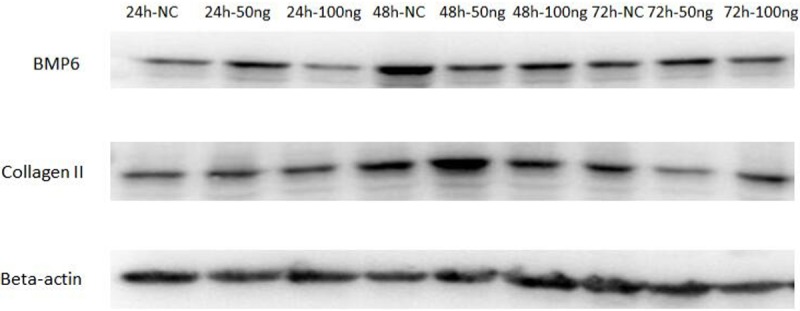
The protein levels of Collagen II (A) and BMP6 (B) by Western blot in cartilage cells after GH induction was significantly increased. The protein beta-actin was used as reference gene.